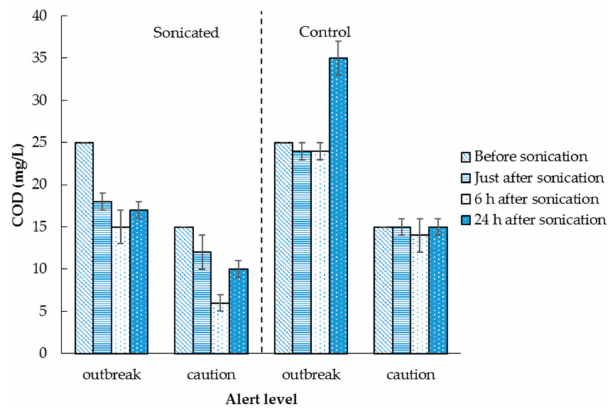
Figure 6. Effect of 15 min of sonication on the chemical oxygen demand (COD) values of the outbreak and caution concentrations, just after sonication and then after standing for 6 and 24